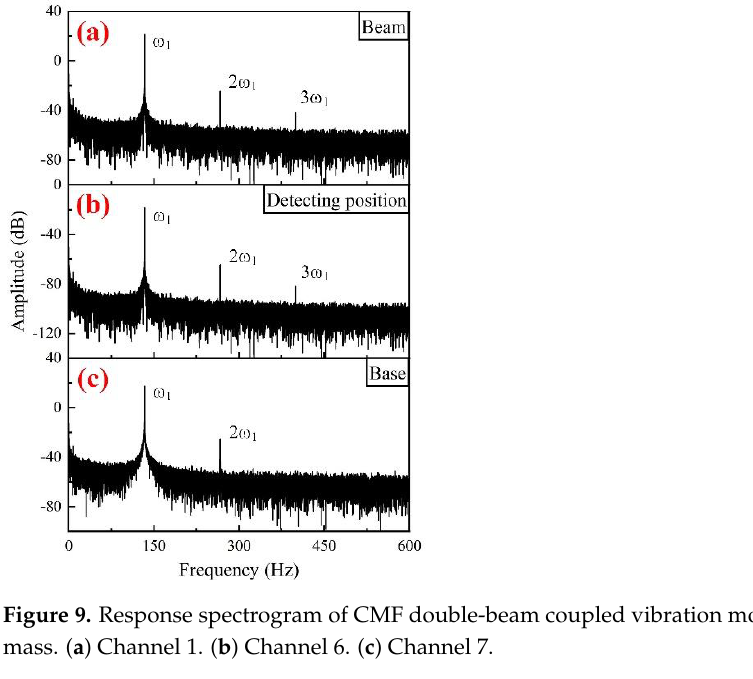
308 Figure 8. Schematic diagram of geometric modelling of dual U tube with fixed electrode distance.